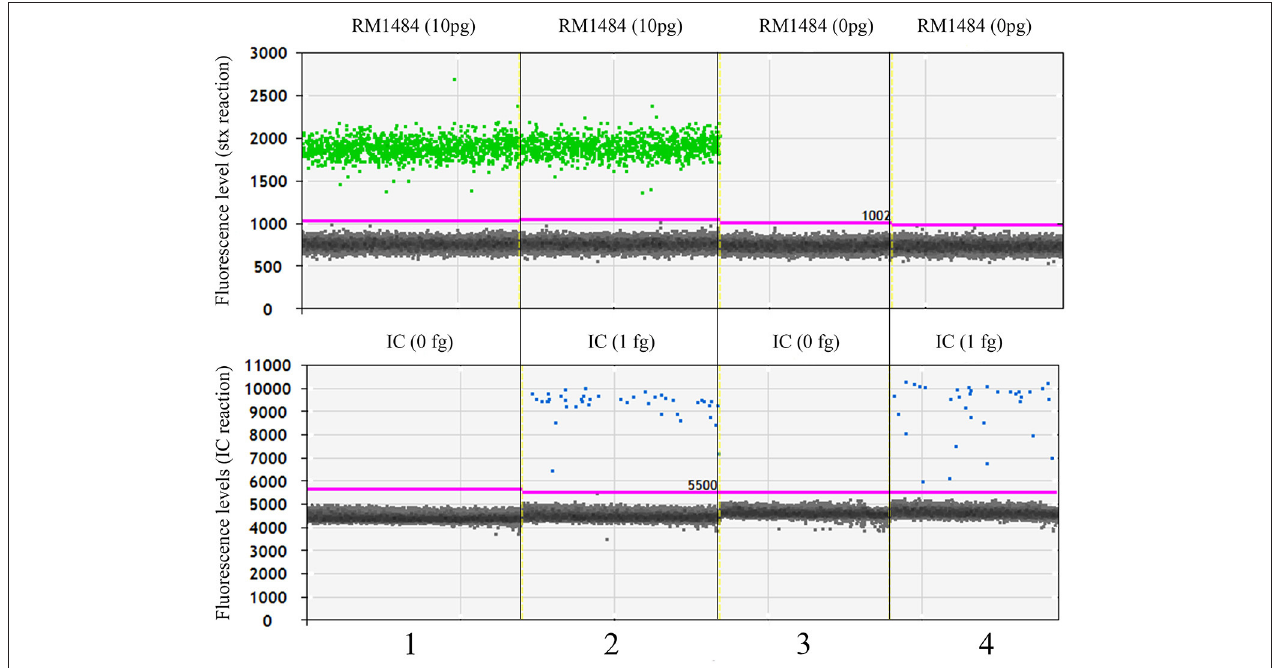
FIGURE 2 | Representative ddPCR display of multiplexed stx 2, IC amplifications. Most droplets displayed basal fluorescence of 750 and 4,500 units for the stx 2 and IC reactions, respectively. Threshold levels are marked in pink and those droplets above these levels are considered positive for the respective amplicon; green, stx 2 positive, blue, IC positive.